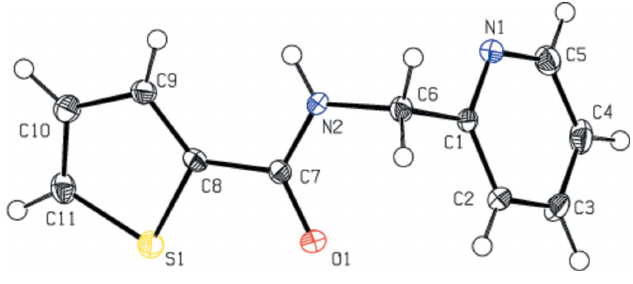
Figure 1 The molecular structure of the title compound, with displacement ellipsoids drawn at the 30% probability